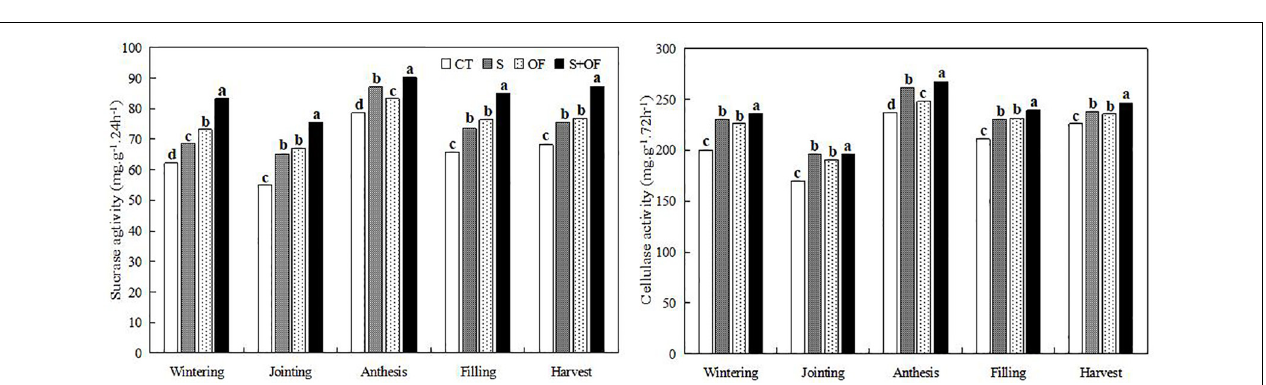
FIGURE 3 | Effects of subsoiling, organic fertilizer and subsoiling combined with organic fertilizer on soil microbial biomass carbon and soil microbial biomass nitrogen at different growth stages of winter wheat in 2019. CT, conventional tillage; S, subsoiling; OF, organic fertilizer; S+OF, organic fertilizer combined with subsoiling. Different lowercase letters in the same growth stage indicate significant differences among treatments by LSD test ( P < 0.05).